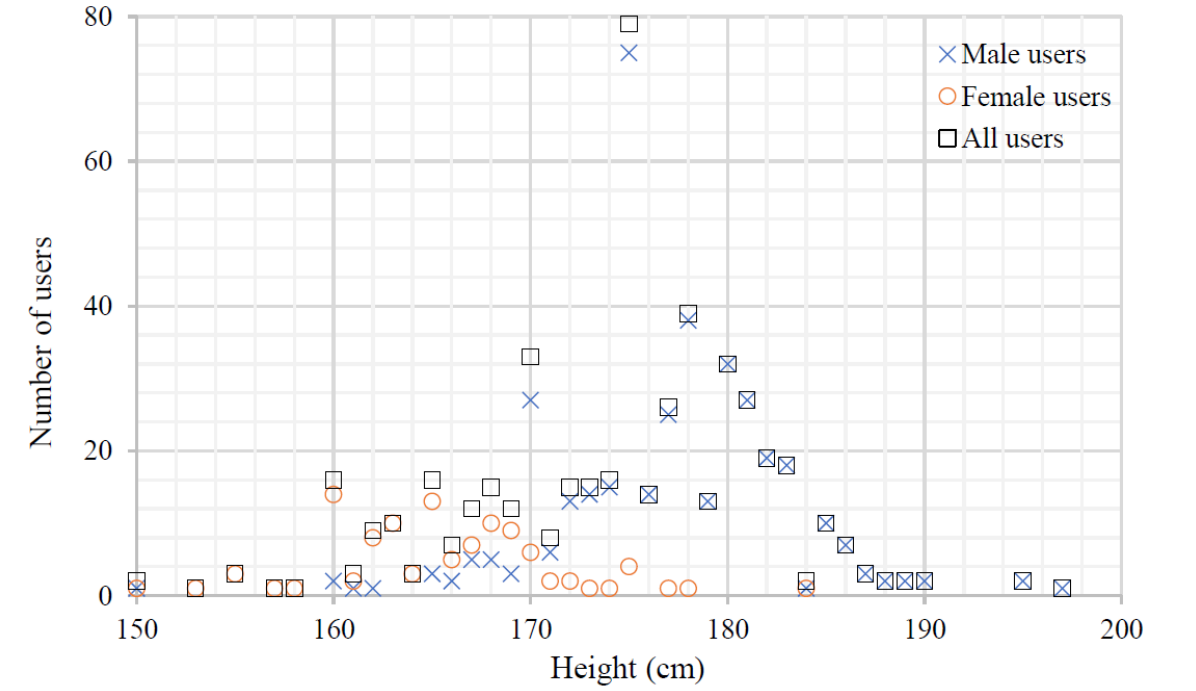
Figure 5. Distribution of height among sexual behavior acquisition system (SeBA).